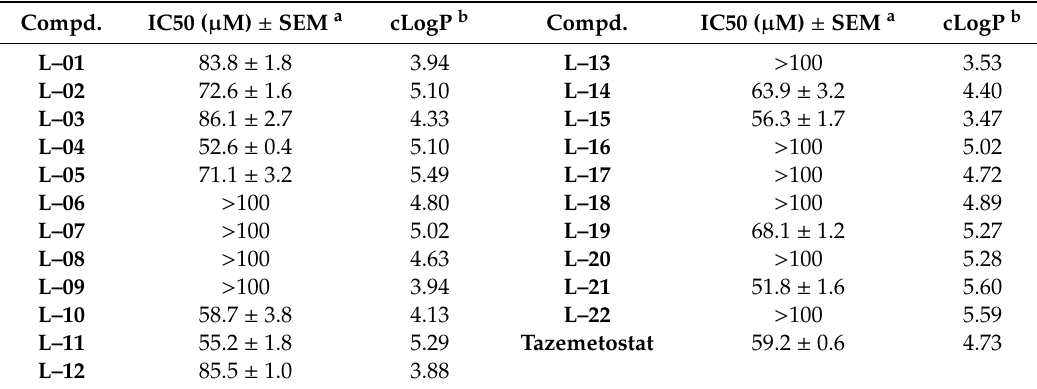
Table 3. Antiproliferative e ff ects of 5-hydroxyindole-based inhibitors against K562 cells.